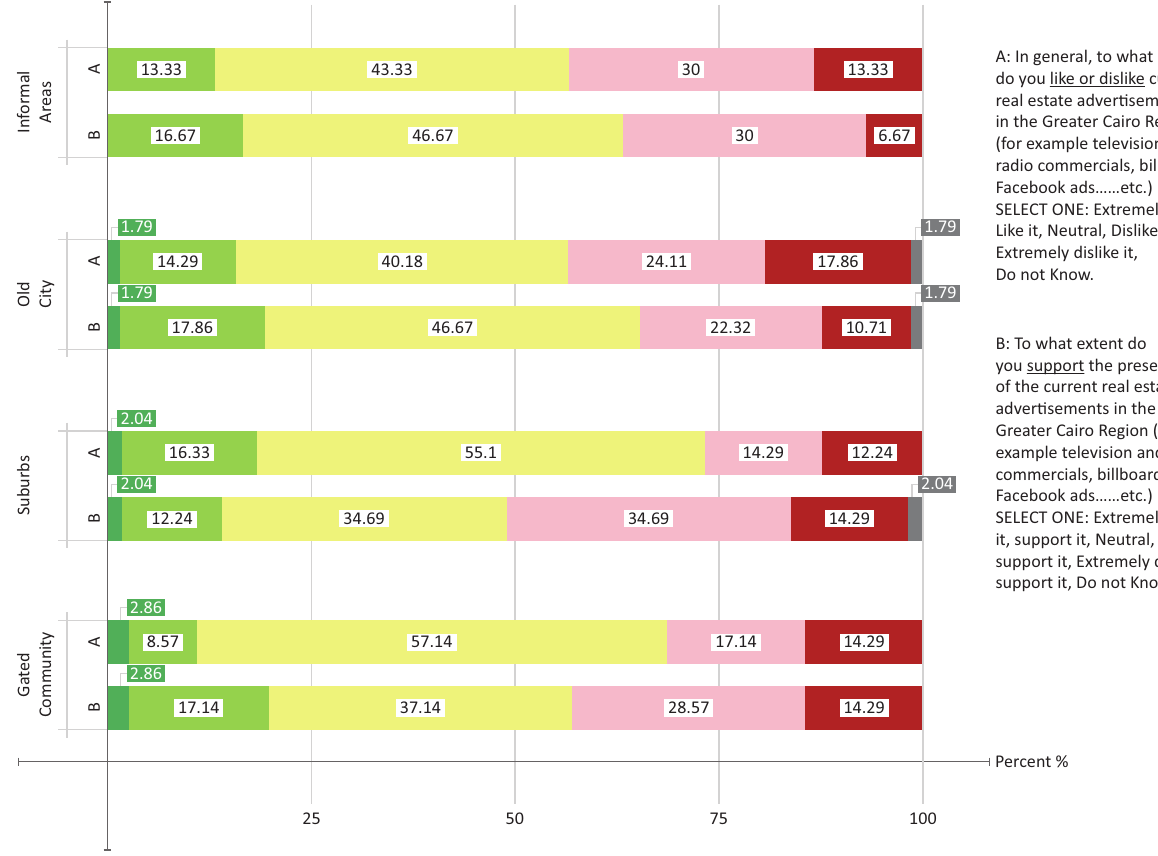
Figure 3. (A) Distribution of the sample by the type of neighborhood and their perceptions/satisfaction about the current real estate advertisements. Source: Author’s calculations (Pearson chi2(20) = 11.4971 Pr = 0.932). (B) Distribution of the sample by the type of neighborhood and their support of the presence of the current real estate advertisements. Source: Author’s calculations (Pearson chi2(20) = 11.4273 Pr =